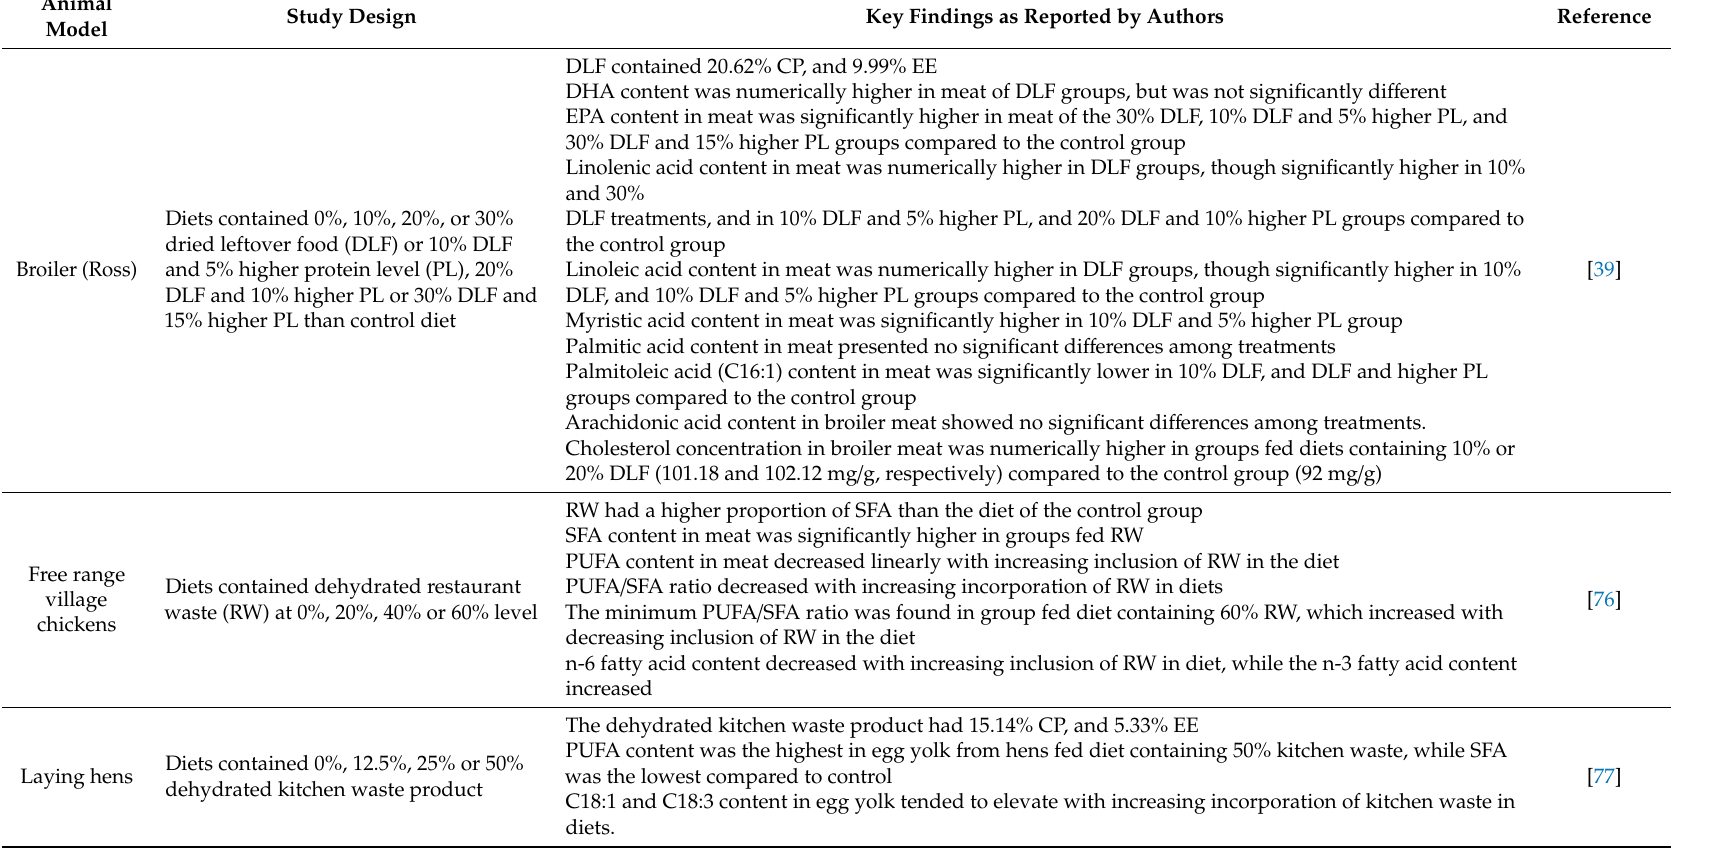
Table 2. A summary of selected studies reporting e ff ects of adding food waste to poultry and pig